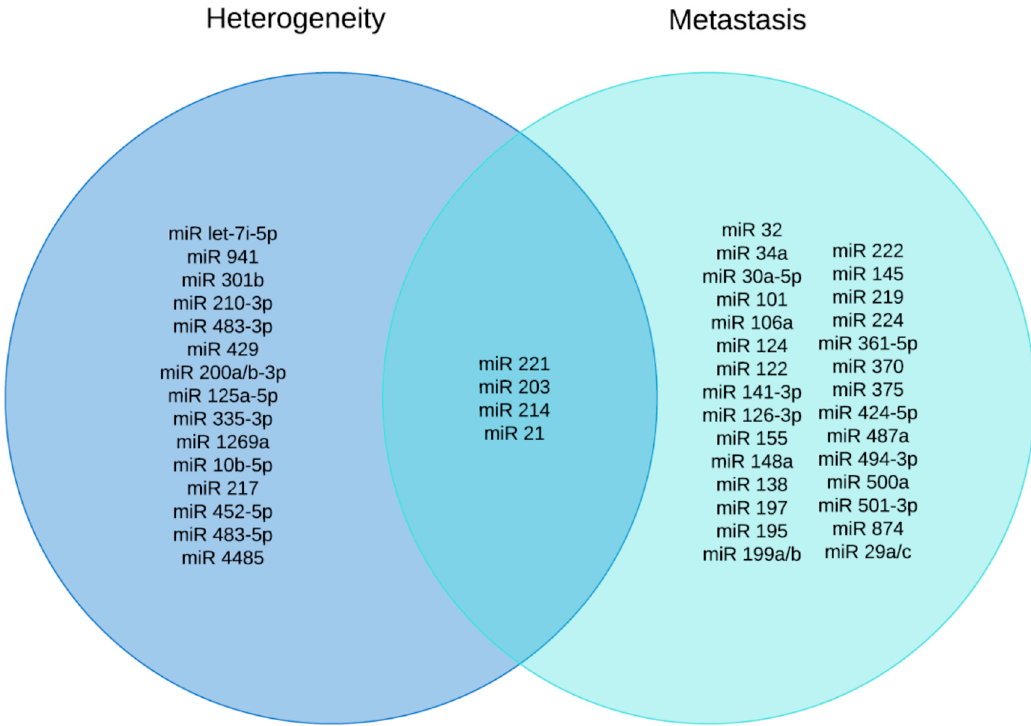
Figure 1. Venn diagram showing a list of microRNAs involved in HCC heterogeneity (19) and metastasis (33). Overlapping region shows microRNAs (4) that are common to both.